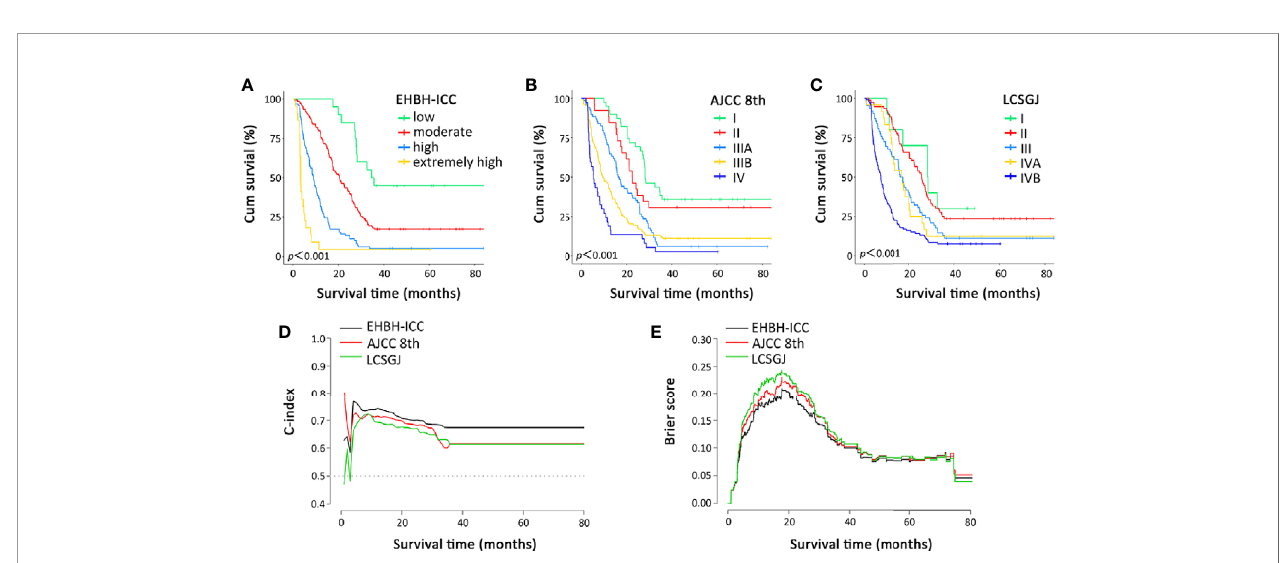
FIGURE 4 | Overall survival curves and prognostic performance indicator curves in the Eastern Hepatobiliary Surgery Hospital-intrahepatic cholangiocarcinoma (EHBH-ICC), American Joint Committee on Cancer (AJCC) 8th, and the Liver Cancer Study Group of Japan (LCSGJ) staging systems. (A – C) depict the overall survival according to the three staging systems in internal validation cohort, all log rank p <0.001. (D, E) present the C-index and brier score change in long-term survival,